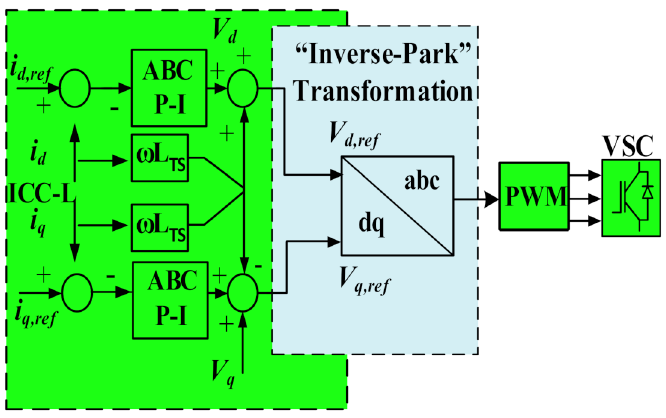
Figure 7. ABC-based control structure of